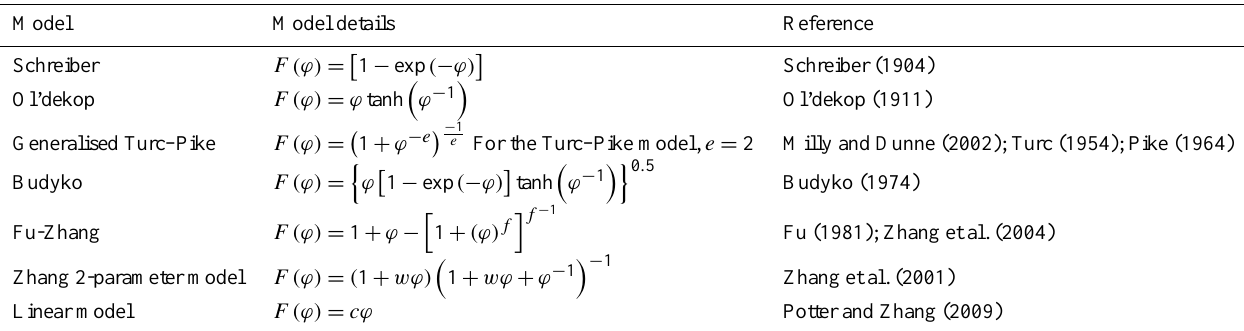
Table 3. Functional relationships for the Budyko-like relationships ( ϕ is the aridity index, e is the Turc–Pike parameter, f is the Fu parameter, w is the plant available water coefficient, and c is a parameter in the linear